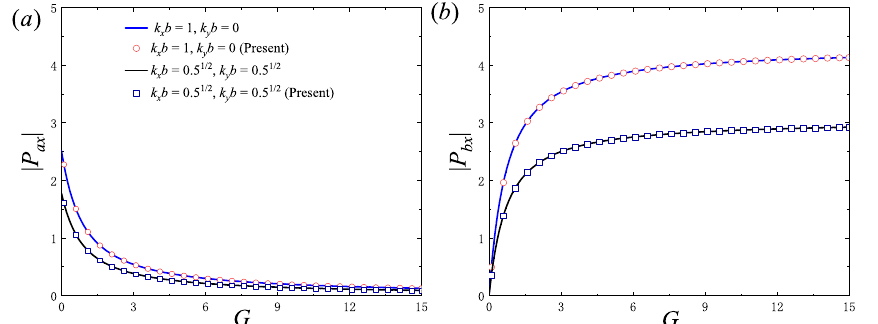
Figure 3. The non-dimensional wave force on a concentric cylindrical system obtained from the present model was compared with the results from Song and Tao [1] (plotted as lines) with a = 4 m, b = 1 m, h / a = 1, kb = 1, γ = 2 π , k x / k = 1, and U 0 = 0: ( a ) exterior cylinder; ( b ) interior cylinder.